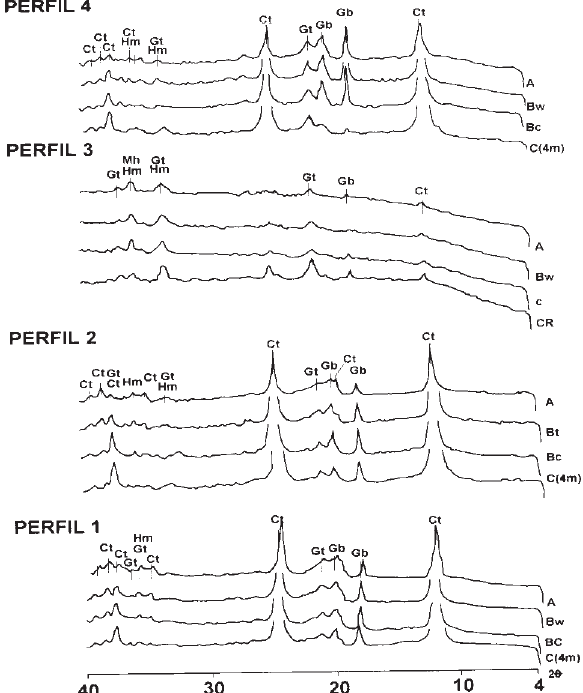
2. Difratogramas de raios X da fração argila dos perfis 1, 2, 3, e 4, sem pré-tratamento, com